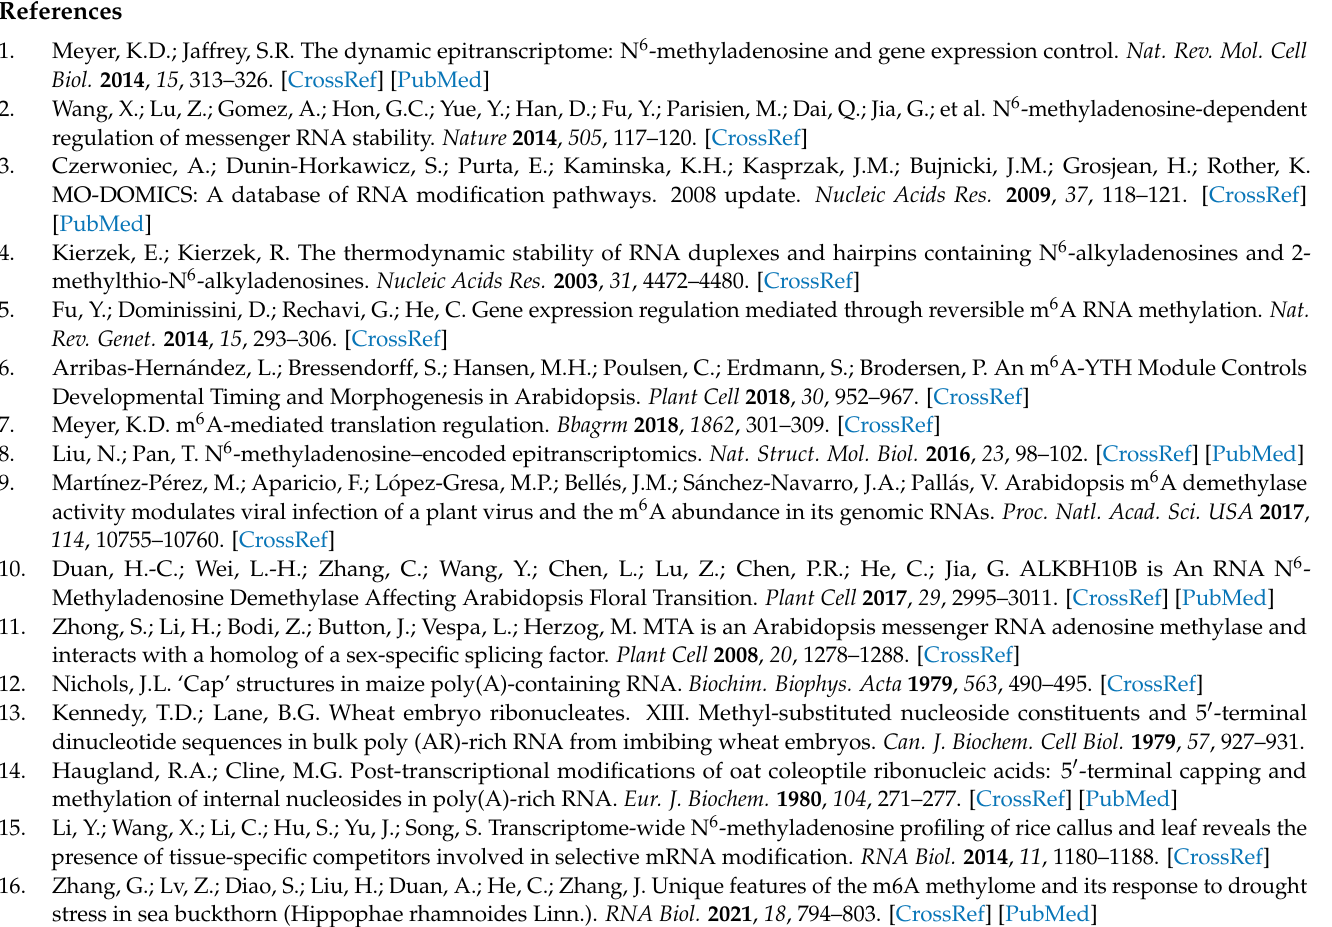
modeling; Table S5: The primers used in qPCR; Figure S1: The results of molecular docking between cis-elements of m6A pathway genes and LBD15. The amino acid residues involved in docking are displayed in sticks and signed a